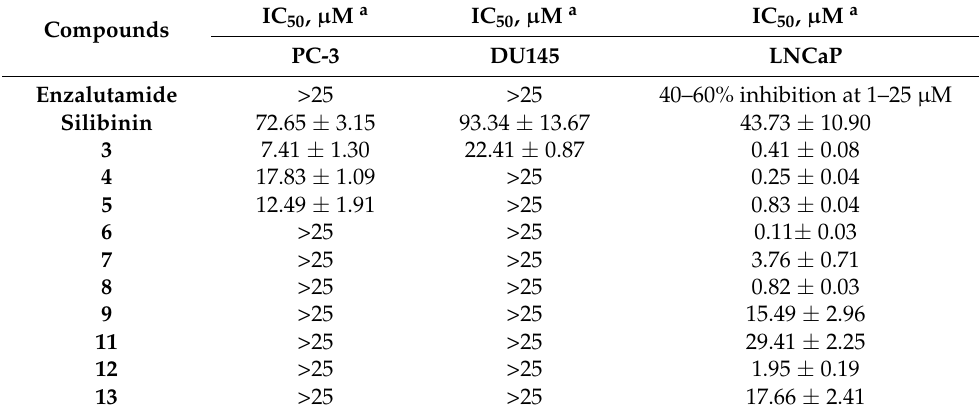
Table 3. Seventy-two hours of antiproliferative activity of carbamoyled 5,7,20- O